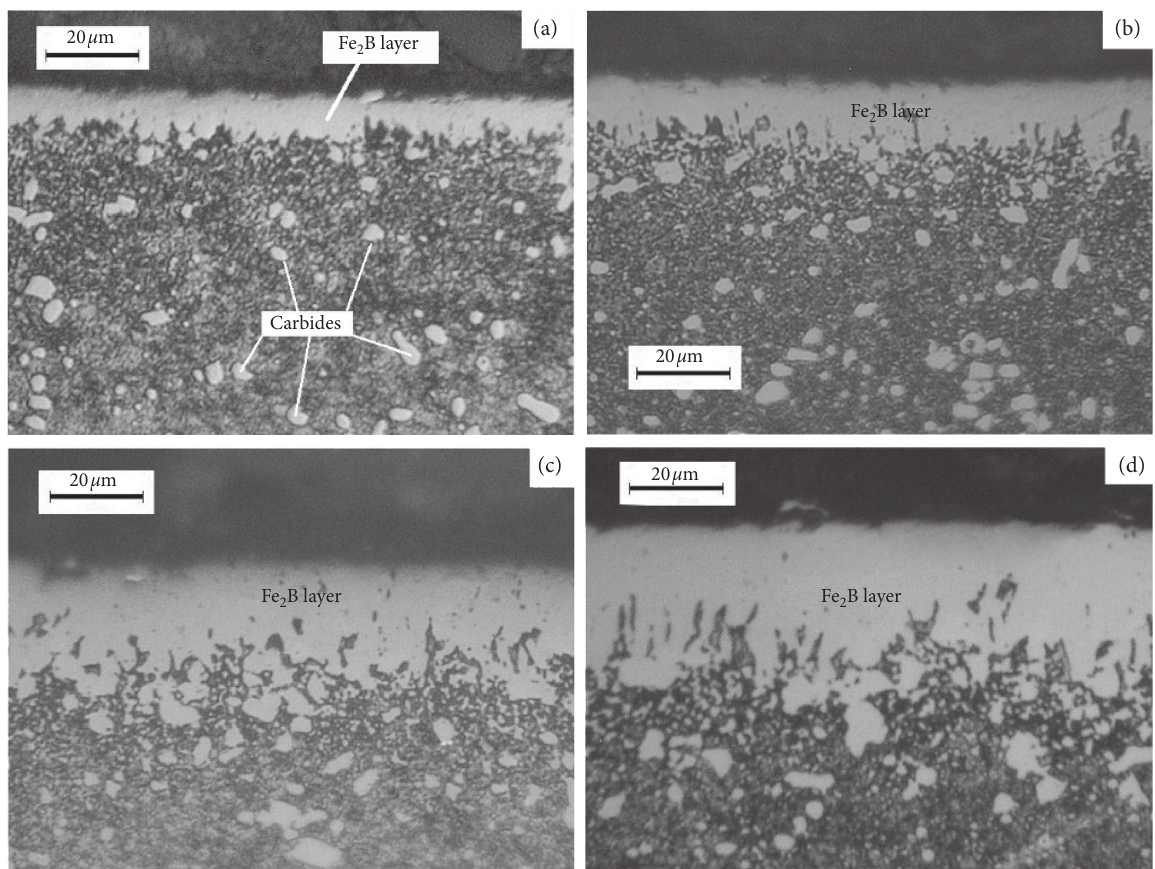
Figure 4: Cross section views of AISI W2 borided steel performed at temperature of 1173K with (a) 2 h, (b) 4 h, (c) 6h, and (d) 8h of exposure.